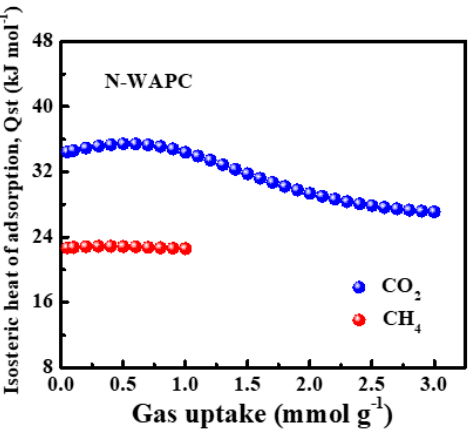
Figure 8. Isosteric heats of adsorption for CO 2 and CH 4 on the N-WAPC.